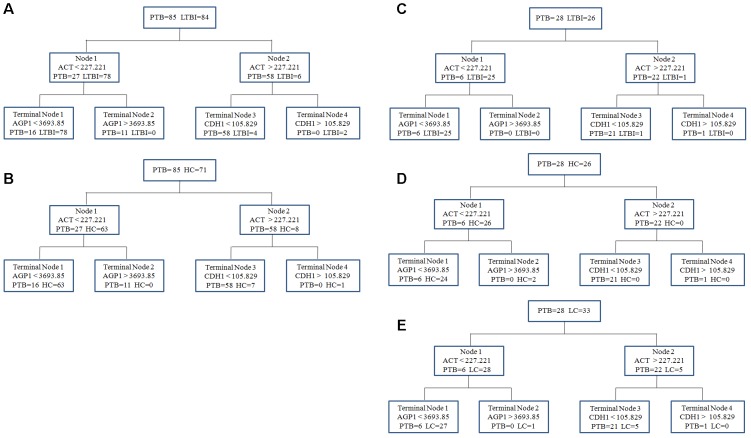
The diagnostic model for distinguishing PTB and non-TB individuals using the classification and regression tree (CART) analysis. (A,B) ACT, AGP1, and CDH1 were incorporated to establish a diagnostic model using CART analysis in the training set. The tree structure and the cutoff values of each node were consistent in discriminating the PTB group from the LTBI and HC groups. (C–E) Validation of the diagnostic model in the blinding test set. Similar with the training set, the diagnostic model performed well to discriminate the PTB group from the three control groups. PTB, pulmonary TB; LTBI, latent tuberculosis infection; HC, healthy control; LC, lung cancer.